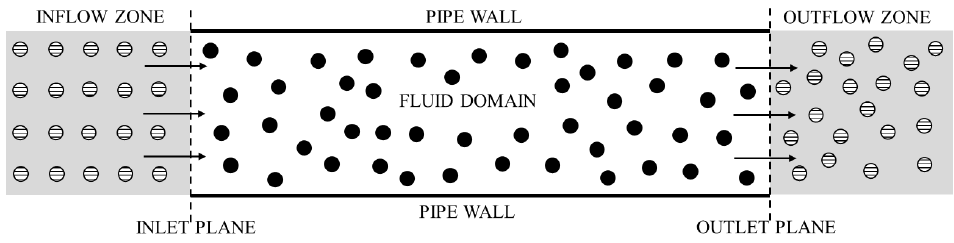
Figure 1. Illustration of the inlet and outlet boundary